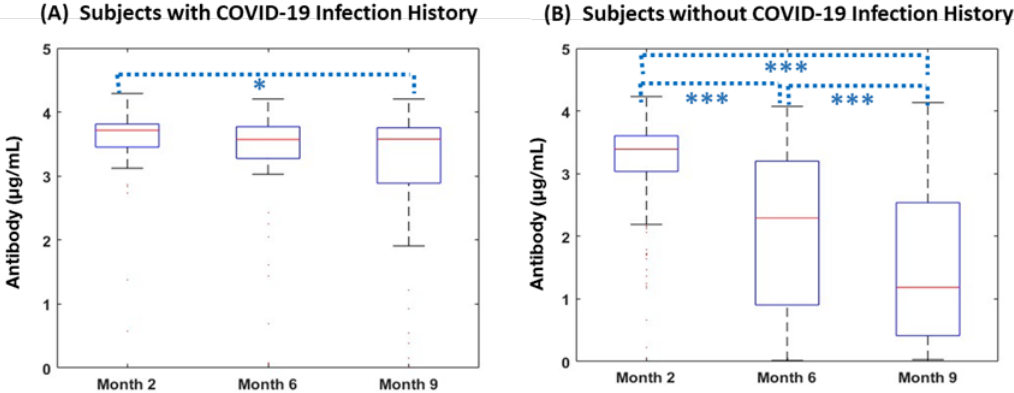
Figure 1. Changes in Antibody over Time per baseline COVID infection history. The following figures indicate ( A ) antibody responses ( µ g/mL) in individuals with COVID history before vaccination at Month 2 (n = 45), Month 6 (n = 44), and Month 9 (n = 34); and ( B ) antibody responses ( µ g/mL) in those without COVID history before vaccination at Month 2 (n = 224), Month6 (n = 227), and Month 9 (n = 143) after the 2nd vaccination. Levels of antibodies in both cohorts significantly decreased over time. Each box and whisker plot indicates the median, IQR, and range of antibody levels. *** p < 0.001, * p < 0.05.